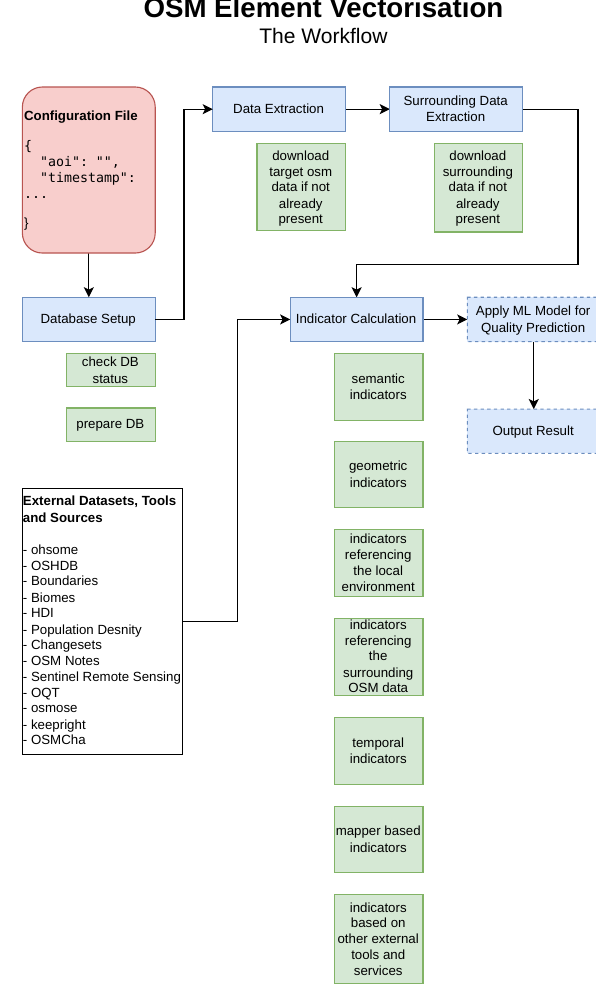
Figure 1. A visual representation of the workflow stages.